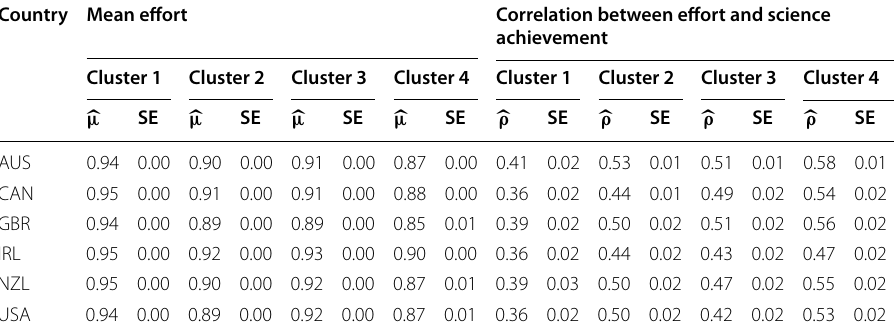
The subsample of students without not‑reached items is composed of 87.96% (first session) and 86.42% (second session) of the students of the total sample